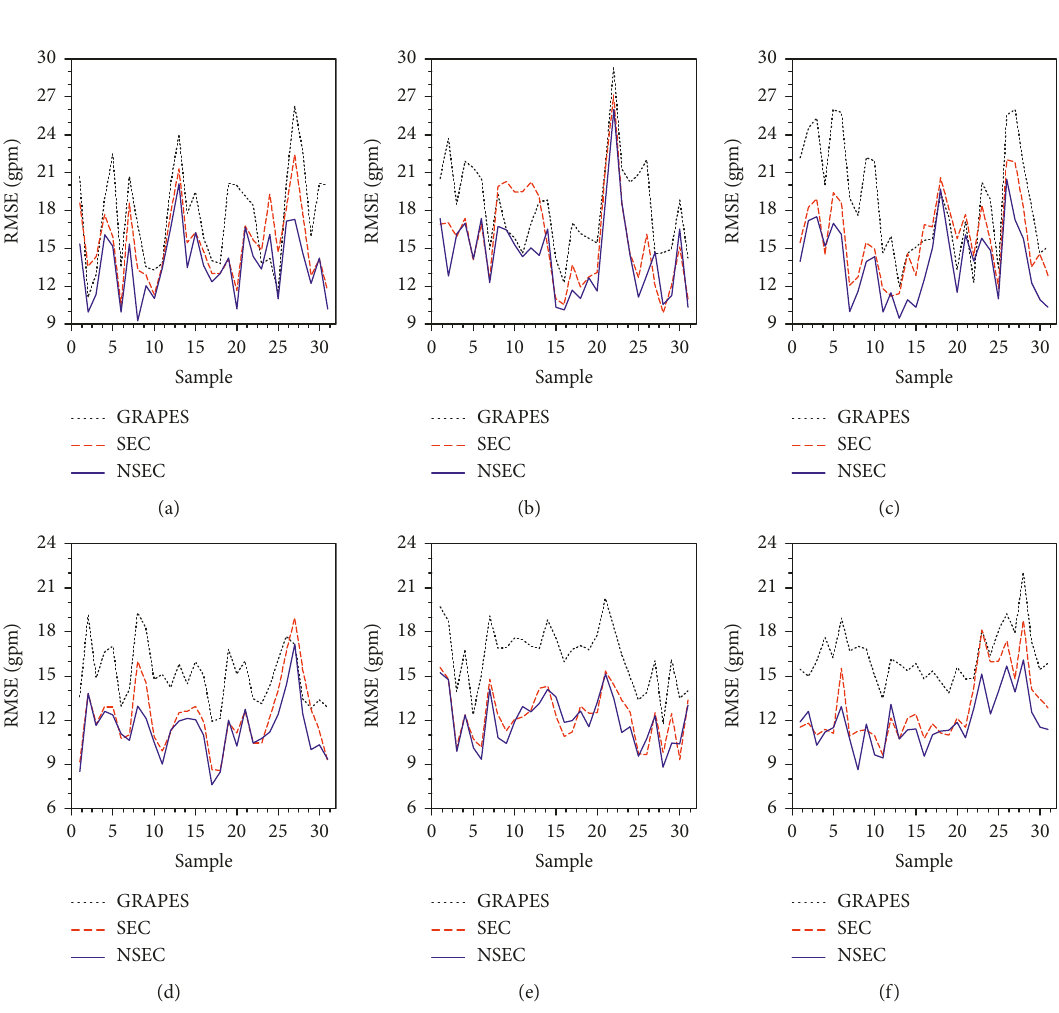
Figure 6: RMSE of 500hPa geopotential height of 48h forecast at January (a, b, and c) and July (d, e, and f) of 2008, 2009, and 2010. The black lines (GRAPES) denote GRAPES model forecast, red lines (SEC) to the forecast after system correction, and blue lines (NSEC) to the forecast after correction of nonsystematic error. Table 5: Average of RMSE of test samples of geopotential height on 500hPa (unit: gpm). Test month GRAPES model Systematic error correction Nonsystematic error correction 2008 Jan.